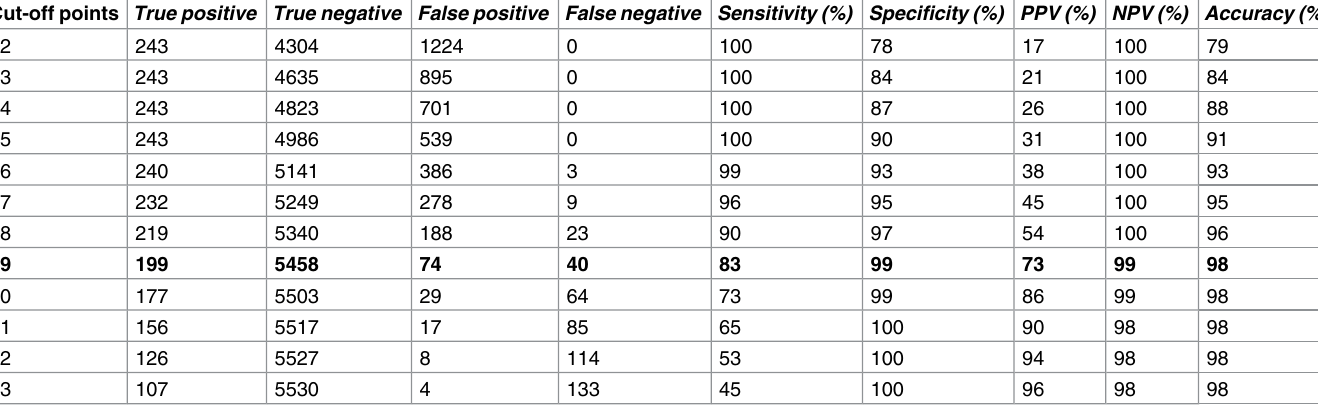
Table 3. Cut-off points based on the third class (i.e., those at-risk of problematic social media use) derived from the Latent Profile Analysis.